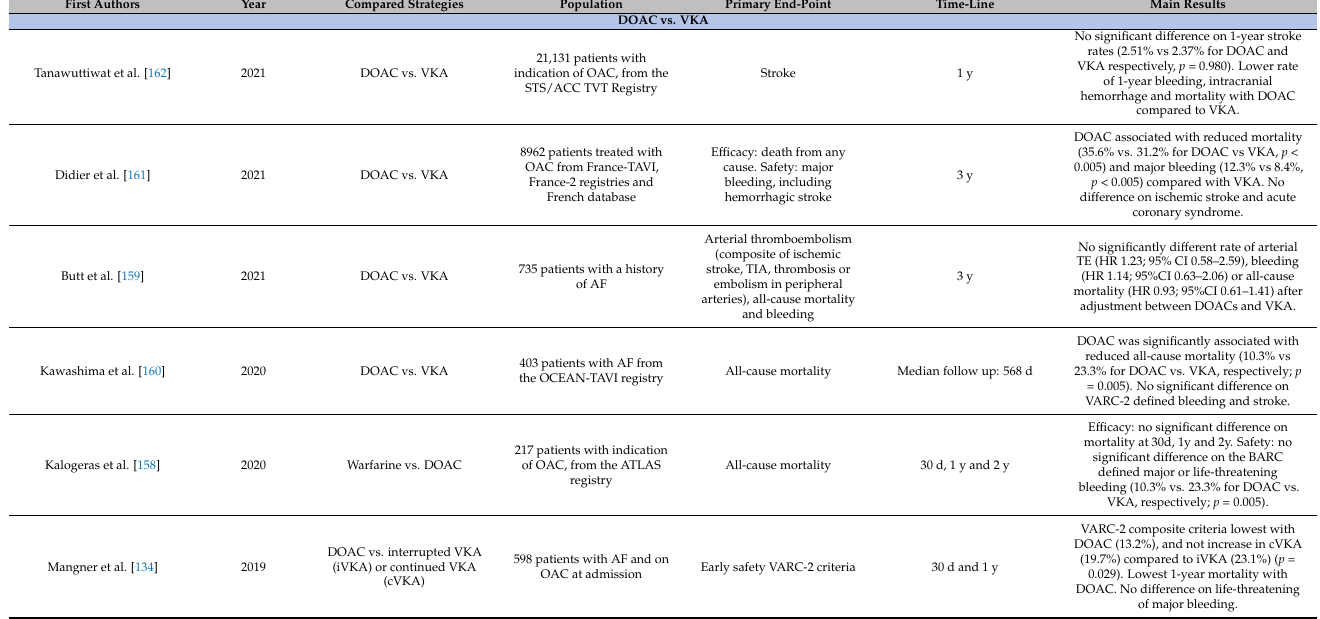
Table 3. Main Observational Studies Evaluating Antithrombotic Therapy After